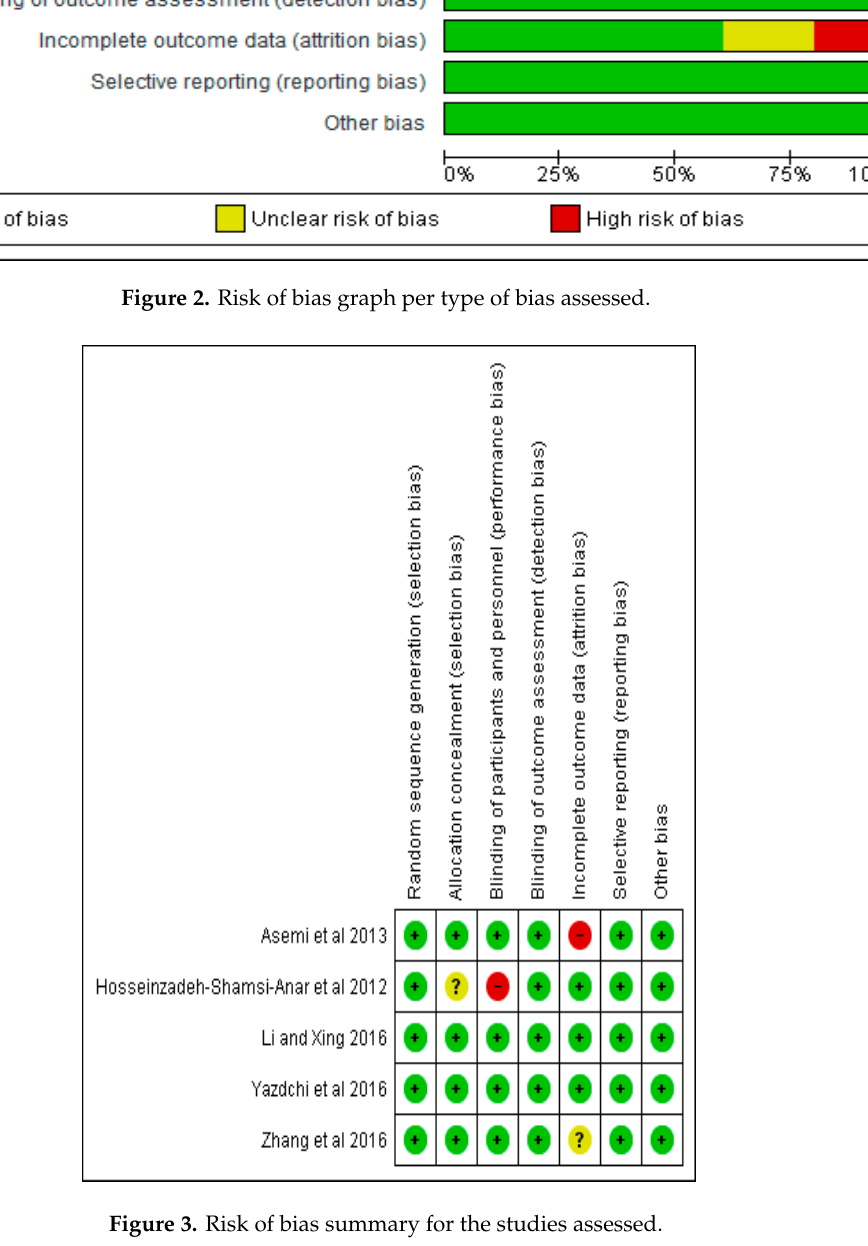
Figure 3. Risk of bias summary for the studies assessed.